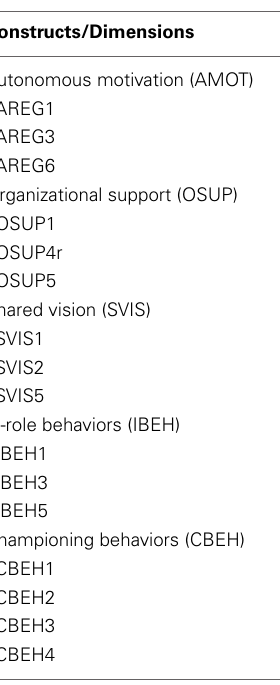
Table 4 | Convergent and discriminant validity statistics.